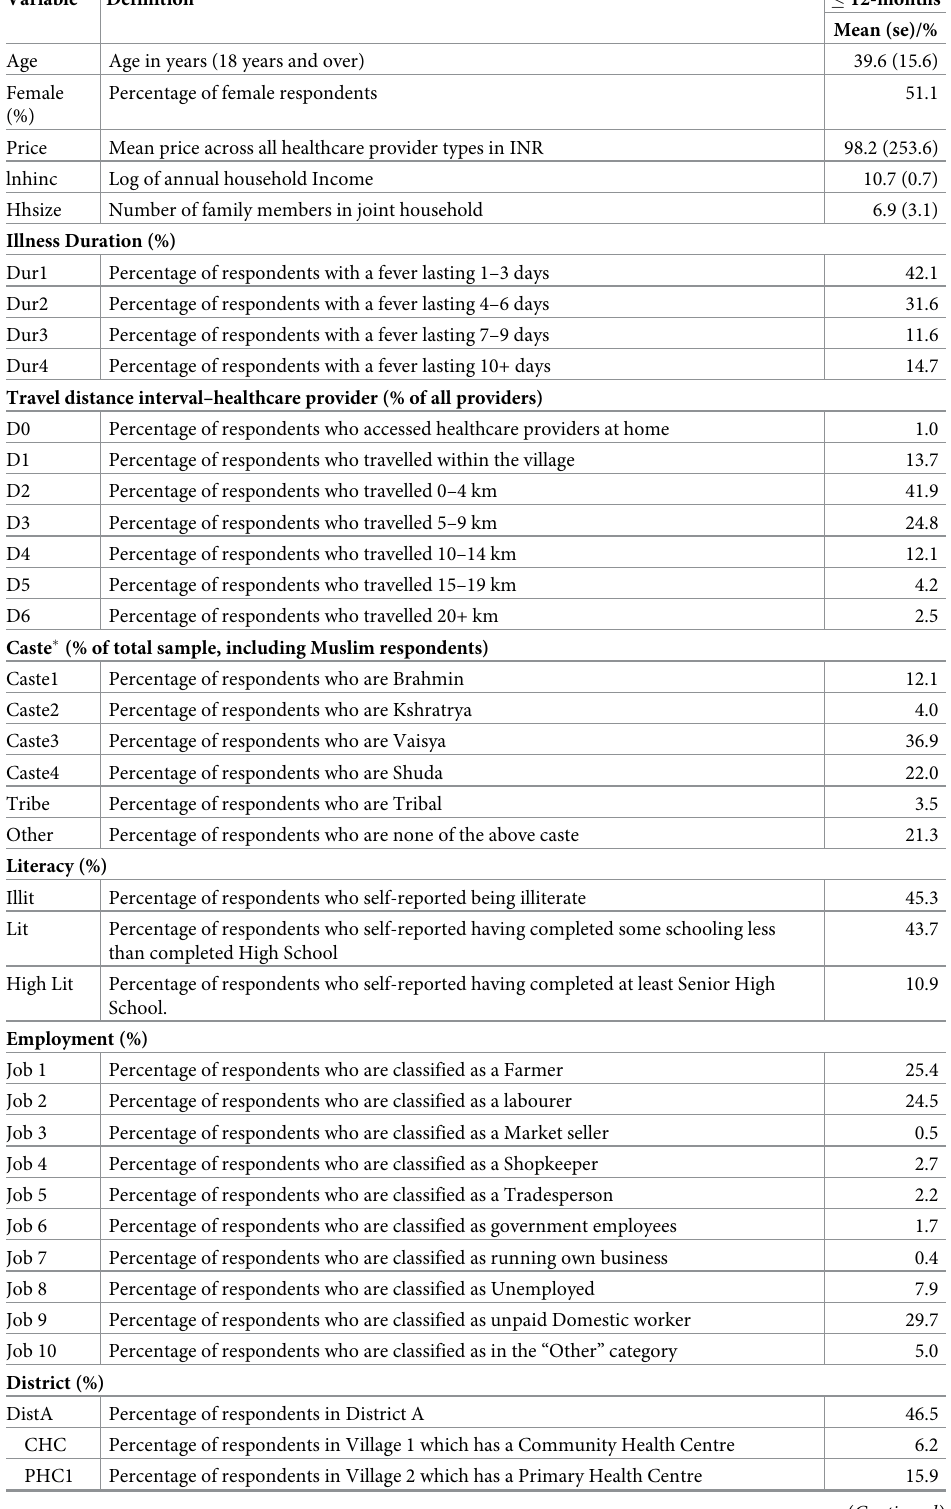
Table 2. Descriptive statistics of (cid:20) 12-month